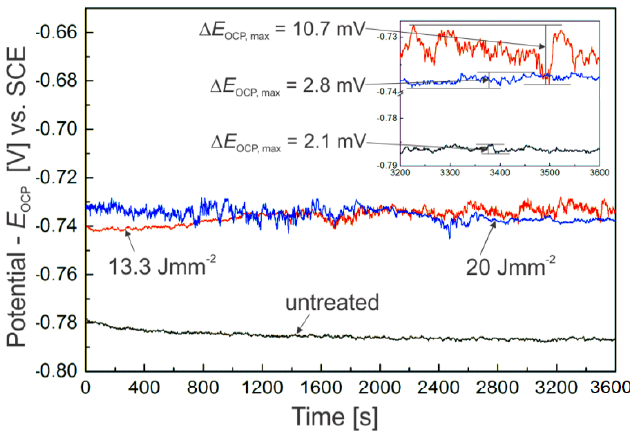
Figure 8. Open circuit potential of di ff erent samples in 0.5 M NaCl solution over a period of 1